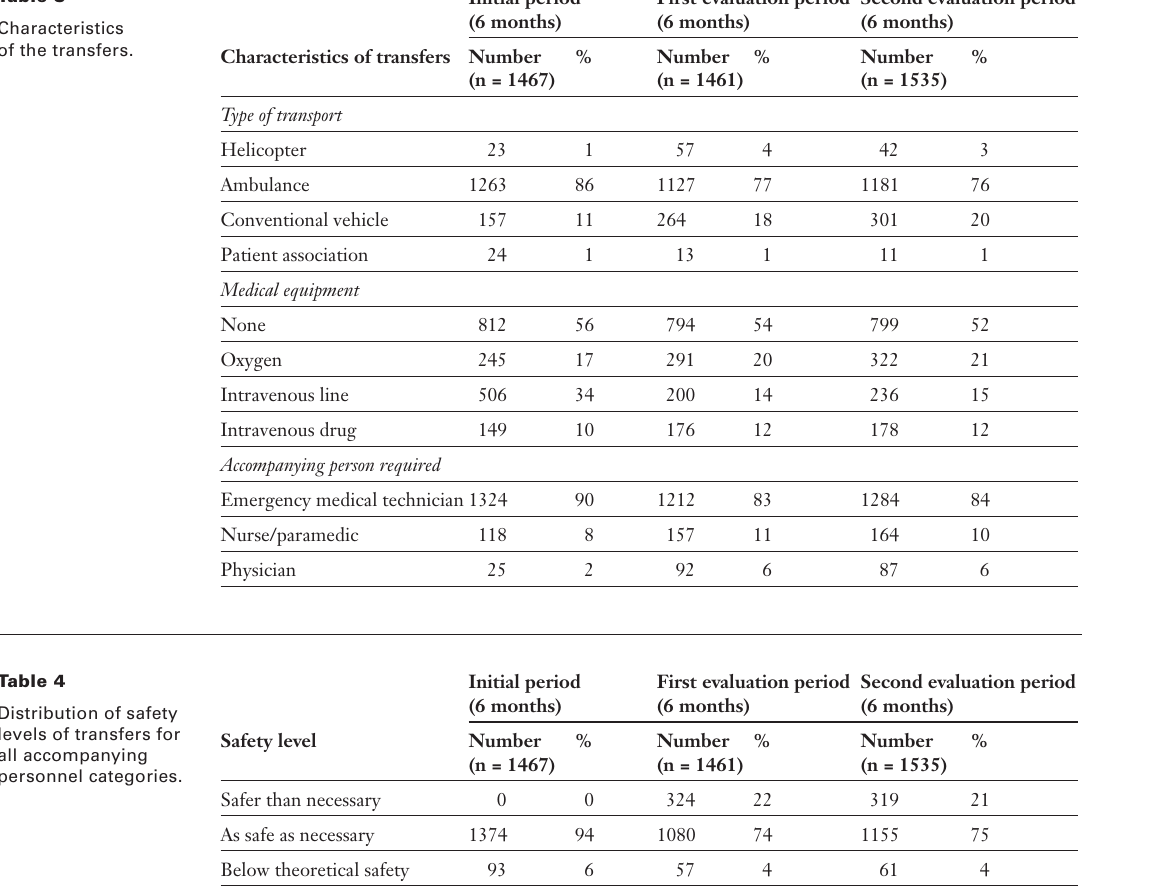
Characteristics of the transfers.